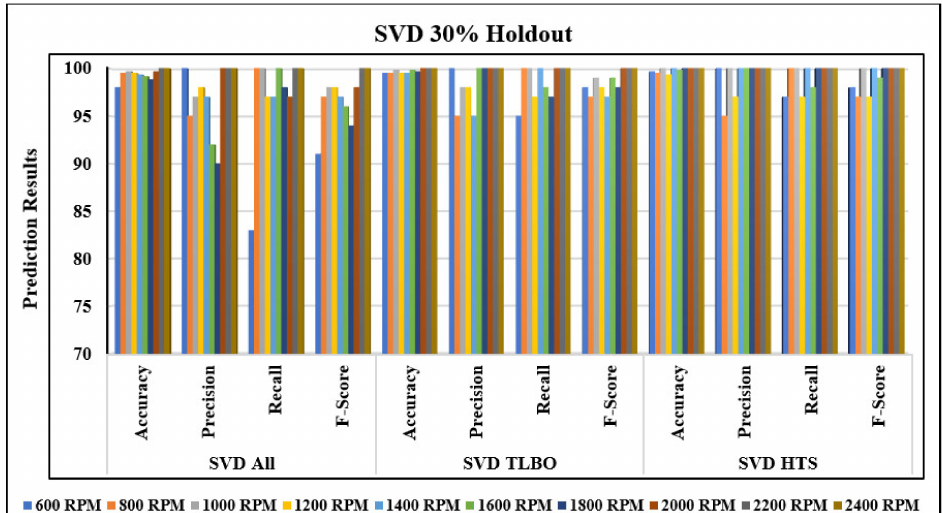
Figure 11. ( a – c ) Compound fault prediction: ( a ) SVM ( b ) SVD, and ( c ) ELM ML models at 30%